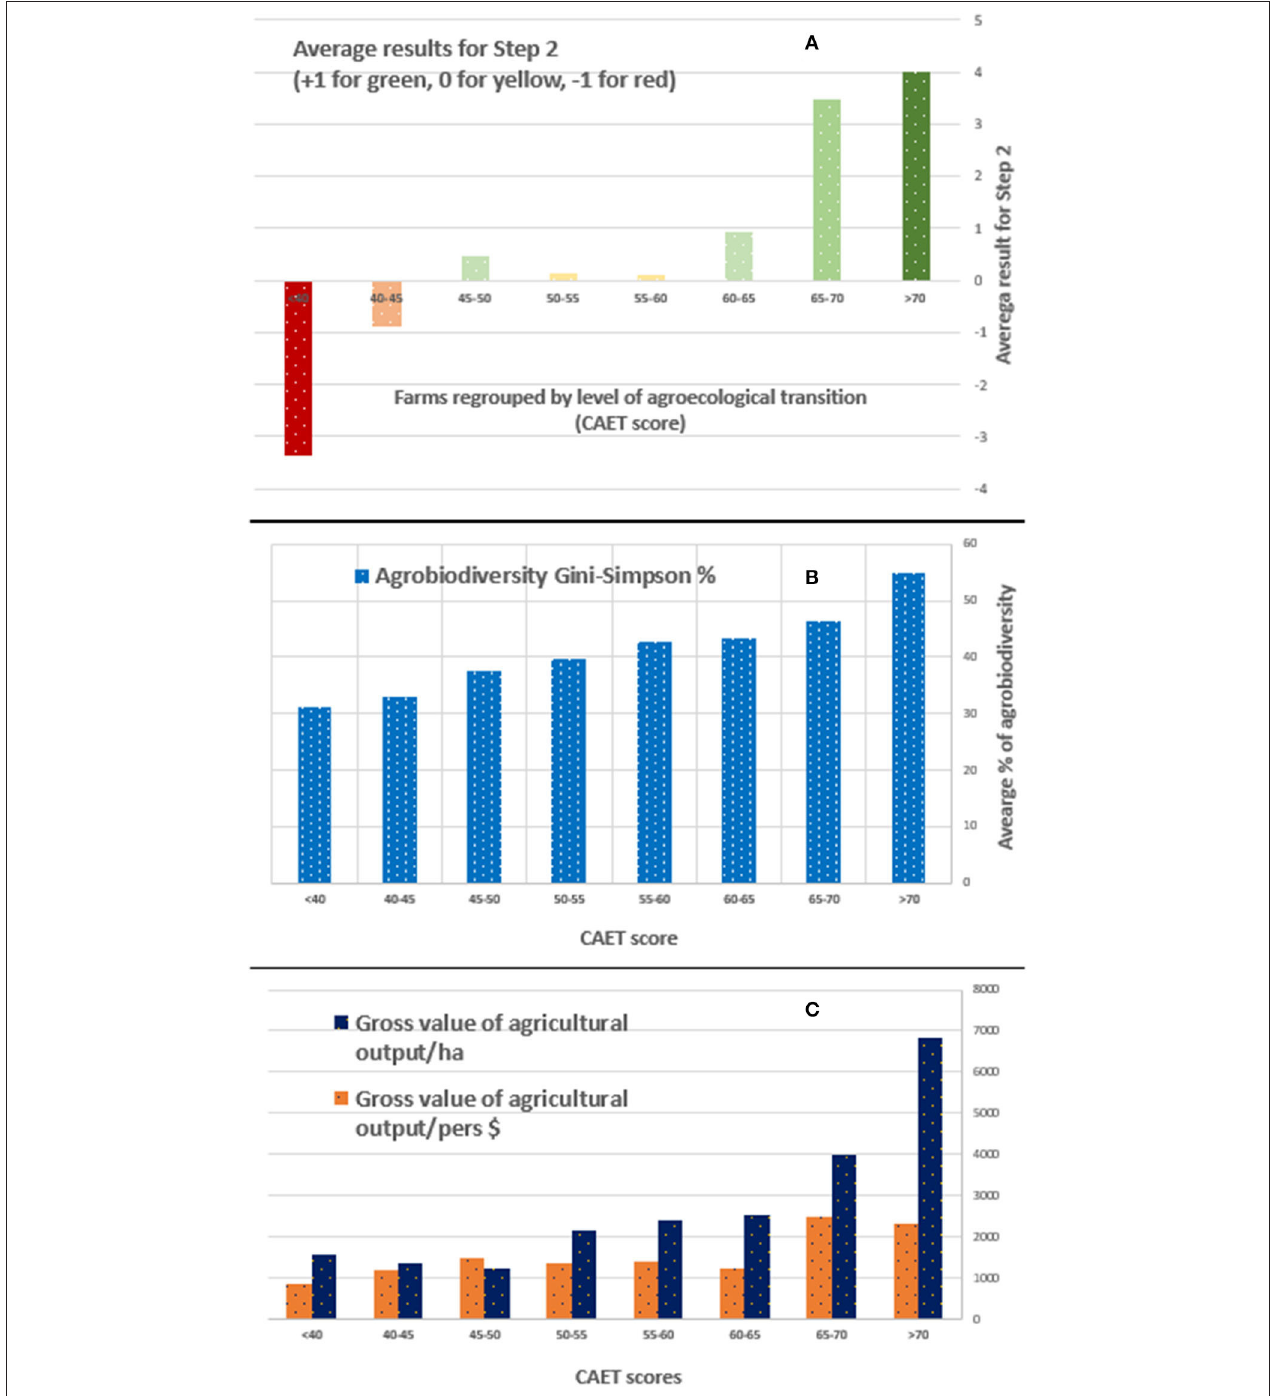
FIGURE 5 | TAPE results from 228 farms in Cambodia. (A) Average score from the traffic light approach (Step 2) per quintiles of CAET (Step 1). (B) Average Gini-Simpson index for agricultural biodiversity (Step 2) per CAET quintiles (Step 1). (C) Average gross value of production per hectare and per person (from Step 2) by CAET quintiles (Step